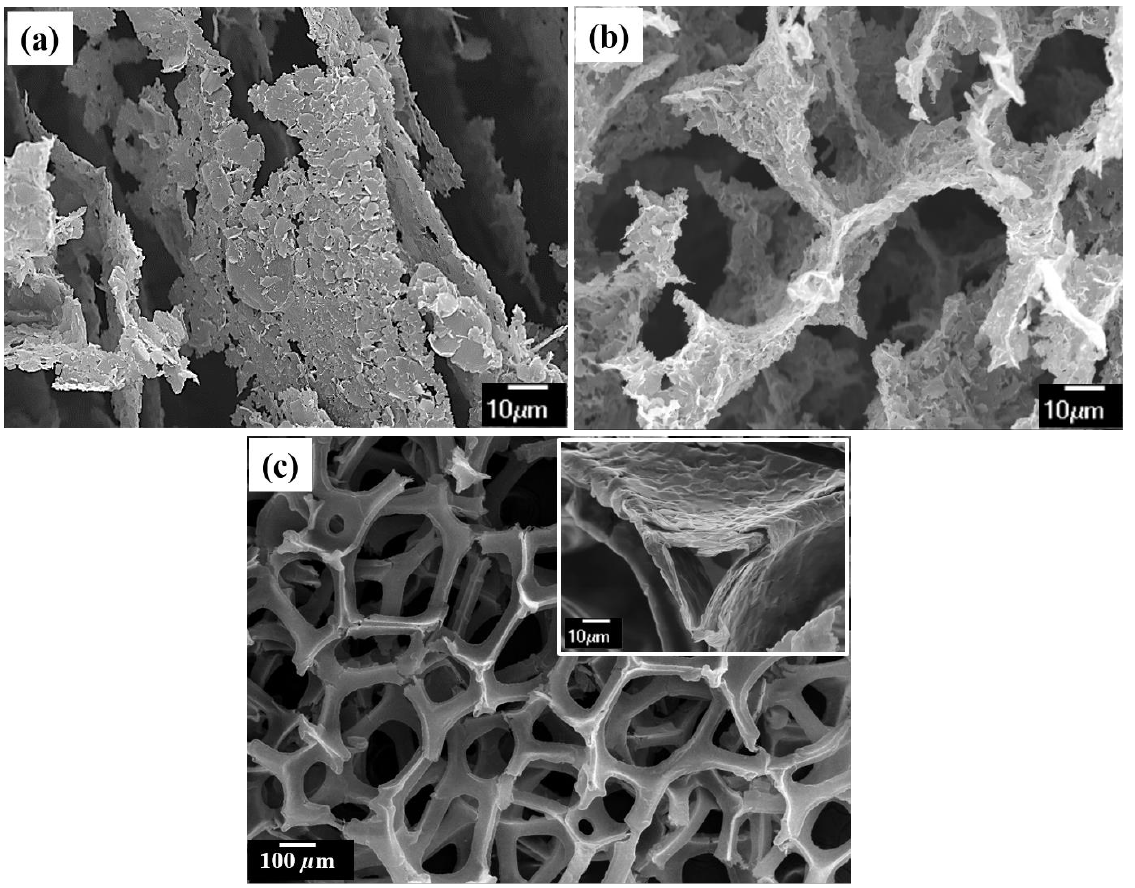
Figure 8. SEM images showing: ( a ) FD 3D GNP foam with basal plane aligned; ( b ) reticulated 3D architecture of FD GNP foam with solid wall or strut; and ( c ) reticulated 3D architecture of CVD GrF with hollow wall or strut (inset showing hollow wall or strut).